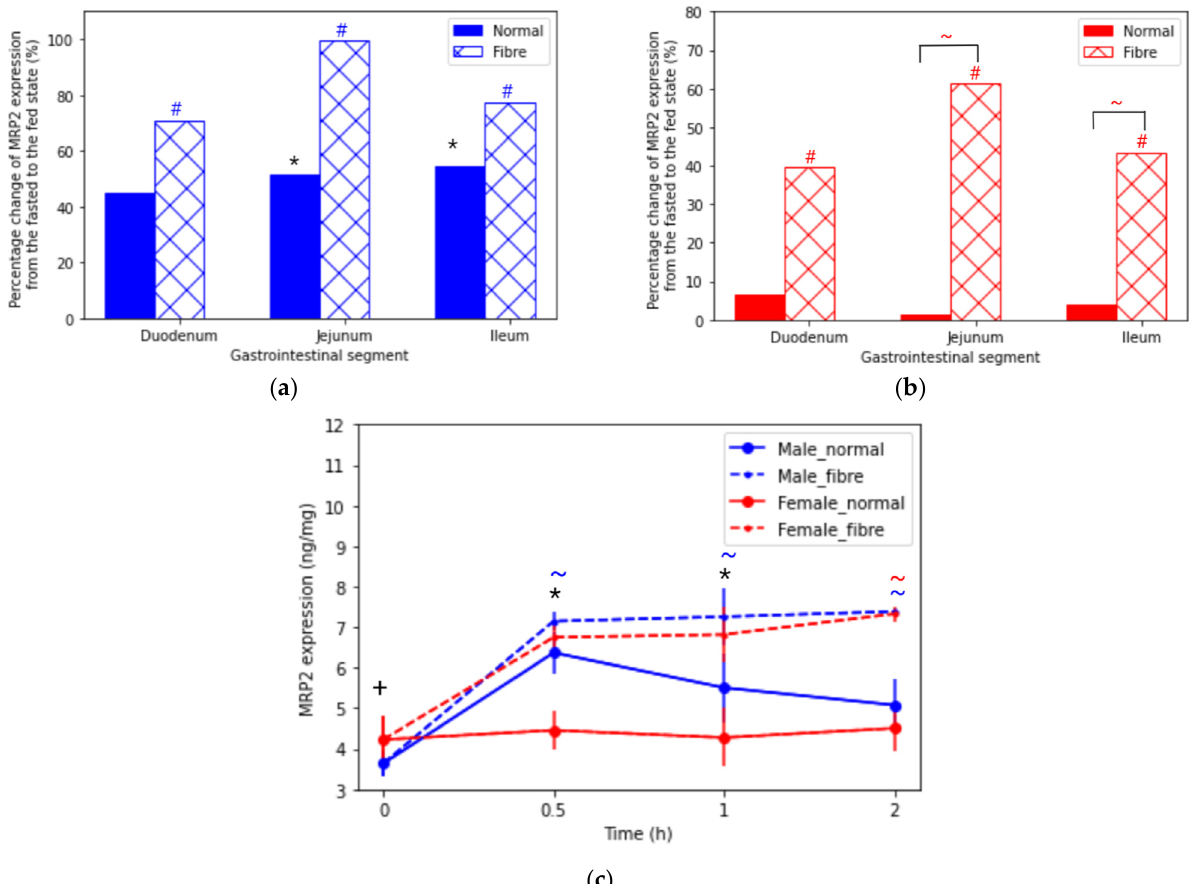
Figure 3. Percentage change in multidrug-resistance-associated protein 2 (MRP2) expression across the intestinal (GI) tract in ( a ) male and ( b ) female rats at time = 1 h from the fasted state to the fed states (normal meal and fibre meal) and ( c ) in the jejunum from time 0 to 2 h under fasted and fed states (normal meal and fibre meal) (mean ± SD) ( n = 6). The following symbols denote a statistical significance ( p < 0.05) showing a sex difference between male and female rats: normal meal (*) and fibre meal (+); and a food effect between the feeding interventions: fasted and fibre (#)and normal and fibre (~).